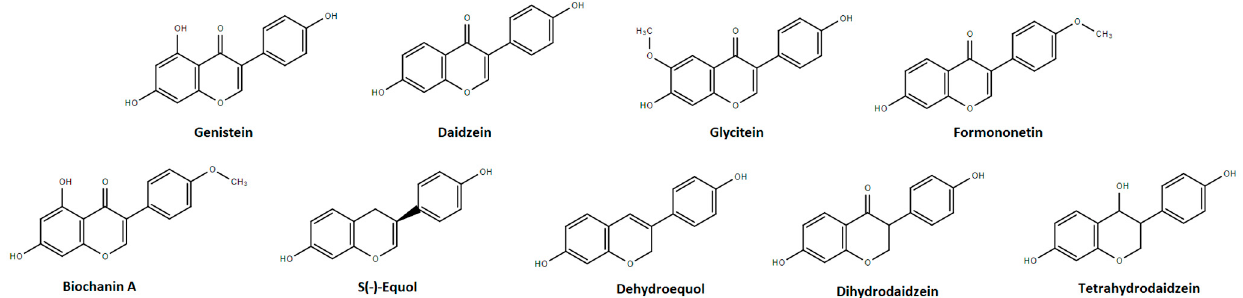
Figure 1. Molecular structure of the five main isoflavones in their aglycone form (genistein, daidzein, glycitein, formononetin, biochanin A) and of the metabolites S( − )-equol, dehydroequol, dihydrodaidzein, and tetrahydrodaidzein.